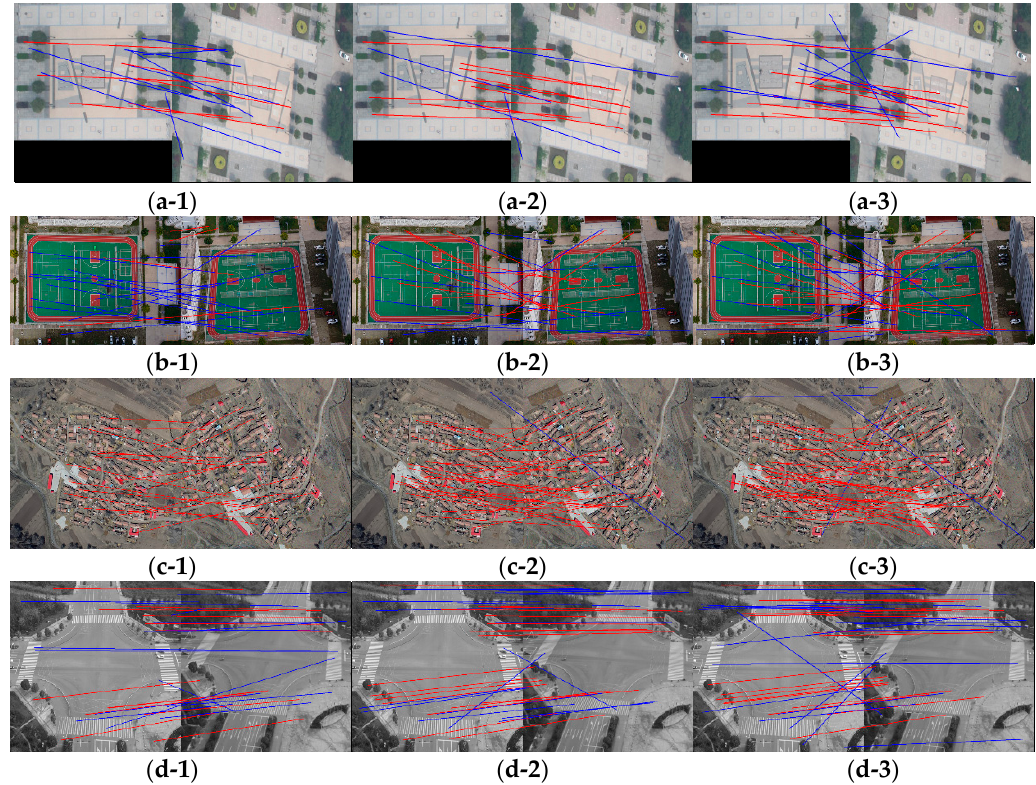
Figure 7. Results of proposed methods for remote sensing images obtained by UAV. The red lines indicate correct matches while the blue lines are incorrect matches. ( a-1 ), ( b-1 ), ( c-1 ) and ( d-1 ) display result of WWF; ( a-2 ), ( b-2 ), ( c-2 ) and ( d-2 ) display result of IWWF; ( a-3 ), ( b-3 ), ( c-3 ) and ( d-3 ) display result of